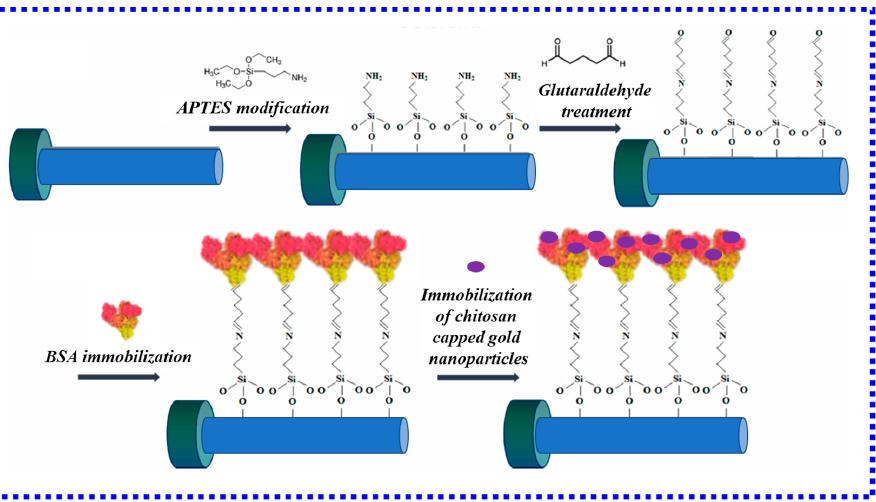
Figure 10. Chitosan-capped gold nanoparticles synthesized and immobilized on bovine serum albumin functionalized optical fiber [77]. Copyright 2023, Elsevier.